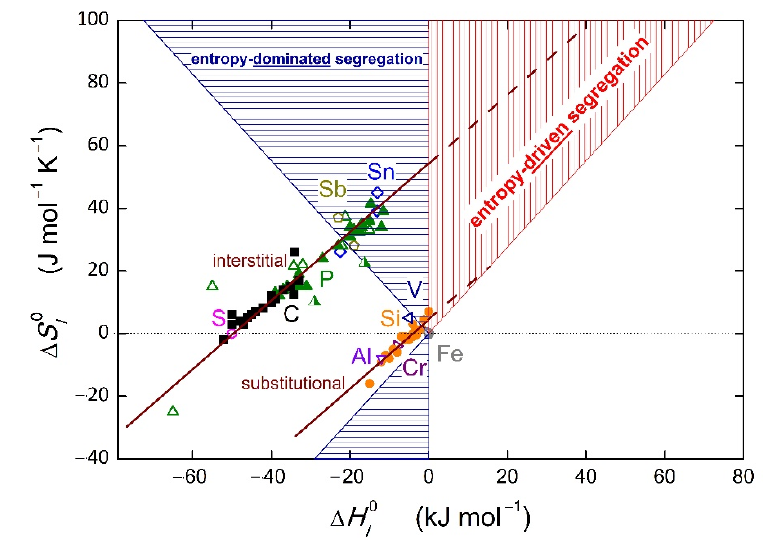
Figure 1. Regions of entropy- dominated grain boundary segregation (horizontal hatching, ∆𝐻 (cid:3010)(cid:2868) ≤ 0 ) and entropy- driven grain boundary segregation (vertical hatching, ∆𝐻 (cid:3010)(cid:2868) > 0 ) for binary iron-based systems with the limiting temperature T = 723 K. Full lines marked as “interstitial” and “substitu- tional” represent the branches of the enthalpy–entropy compensation effect, Equation (7) from [10], and the dashed lines represent their respective extrapolations (the slope of these lines is the recip- rocal value of T CE , 1/900 K − 1 in both cases). Various symbols represent the experimental values of segregation of numerous solutes at individual grain boundaries, data from [7,10].